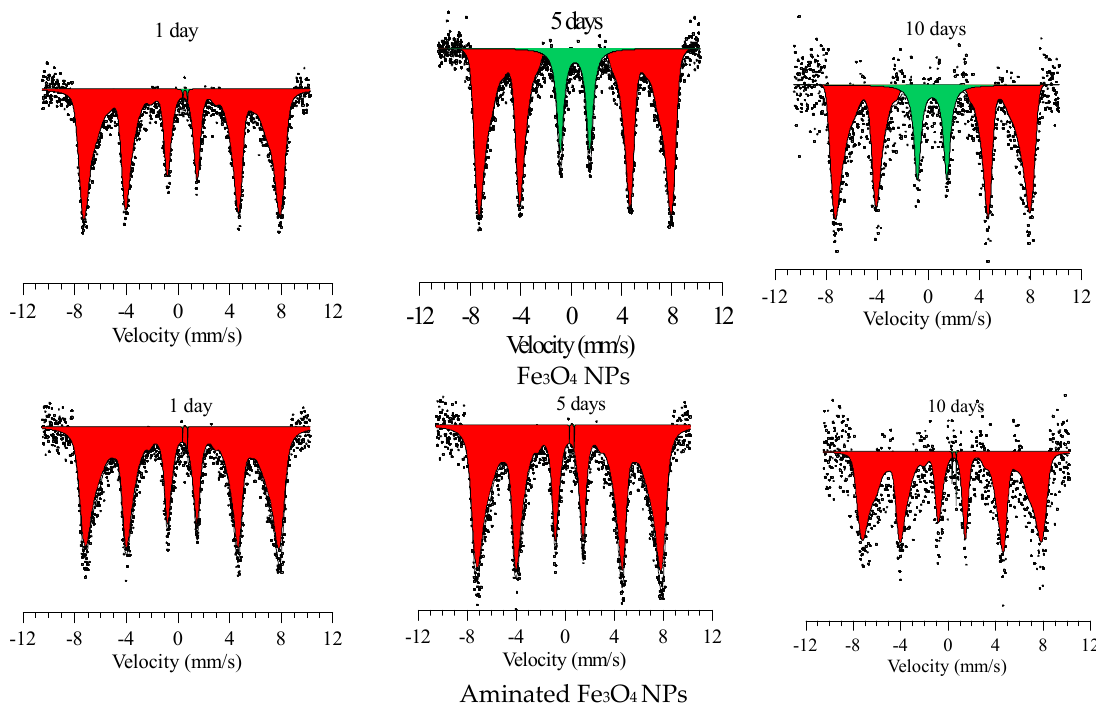
Figure 5. Mössbauer spectra of the studied nanoparticles.